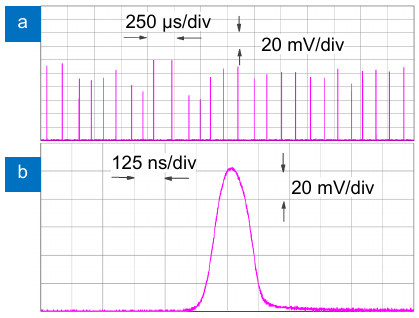
Fig. 8 | ( a ) Typical pules train with PRF of 7.14 kHz at the maxi- mum PQS output power. ( b ) Detail view of the shortest pulse with a width of 145 ns at the maximum output